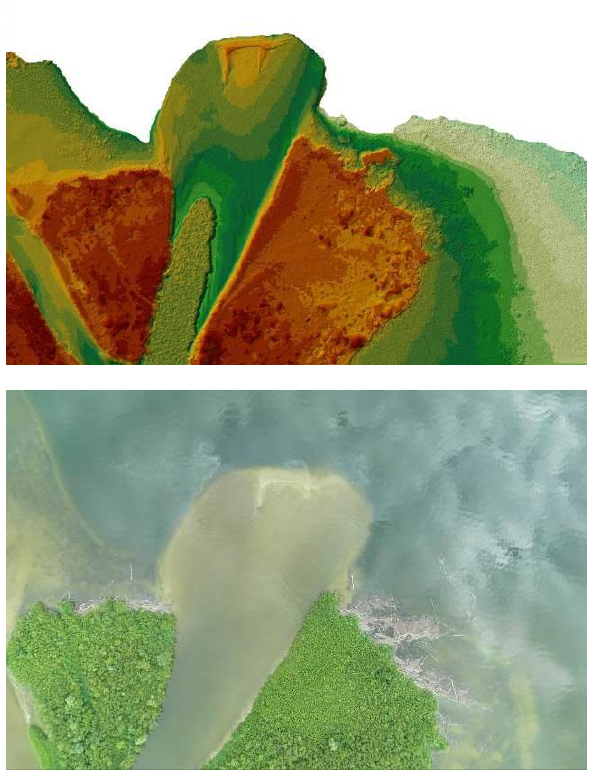
Figure 7 and 8: The estuary of Lake Ammersee showing a fine mesh and its corresponding aerial